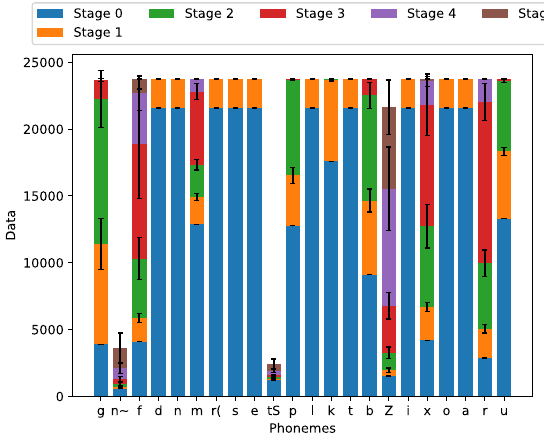
Figure 5. Corpora enrichment for the six scenarios for ι , κ , ξ and σ